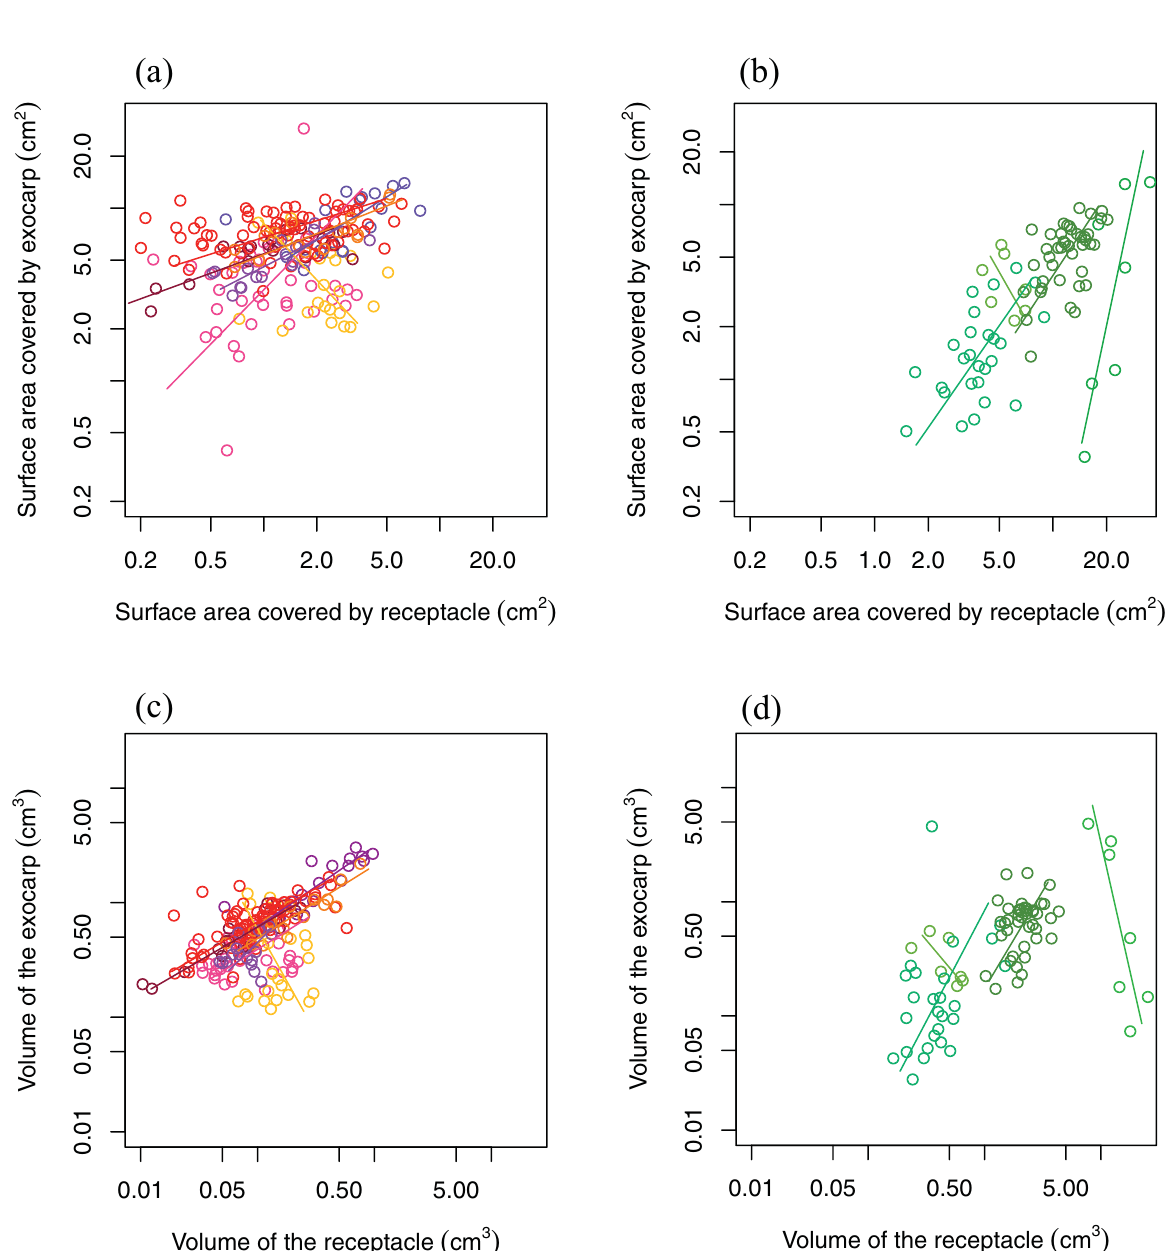
Fig 4. The intraspecific variation of the two fruit types. (a) The seed coverage by exocarp and receptacle of AC species. (b) The seed coverage by exocarp and receptacle of ER species. (c) The volume of exocarp and receptacle of AC species. (d) The volume of exocarp and receptacle of ER species. The scale of (a) and (b) are standardized as the scales in Fig 3 (A). The scale of (c) and (d) are standardized as the scales in Fig 3 (B). There are 7 AC species in (a) and (c), each species is represented by a specific color with the total of 16 or more fruits. There are 4 ER species in (b) and (d) each species is represented by a specific color with the total of 7 or more fruits. Each circle represents a single